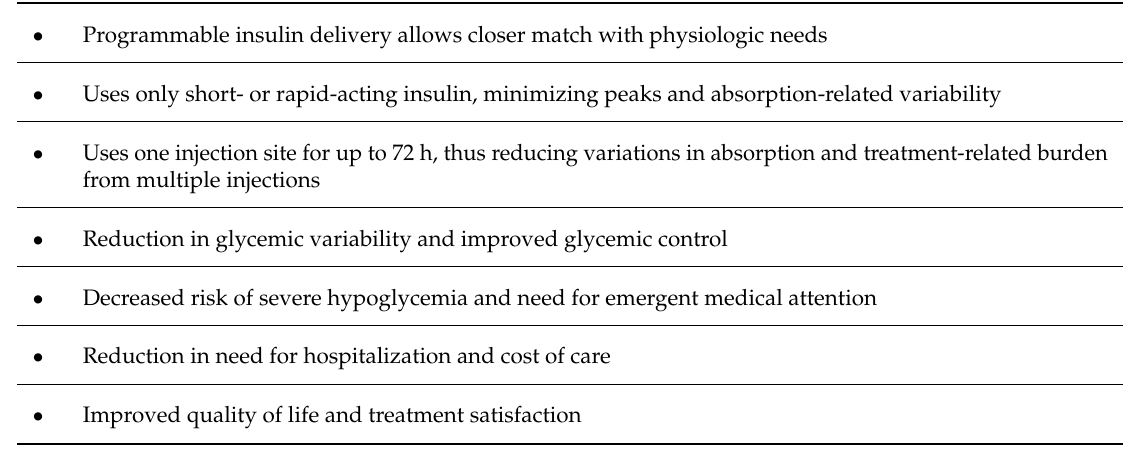
Table 1. Potential Advantages of Continuous Subcutaneous Insulin Infusion (Insulin Pump Therapy) when compared to Multiple ‐ Dose Insulin Injections.